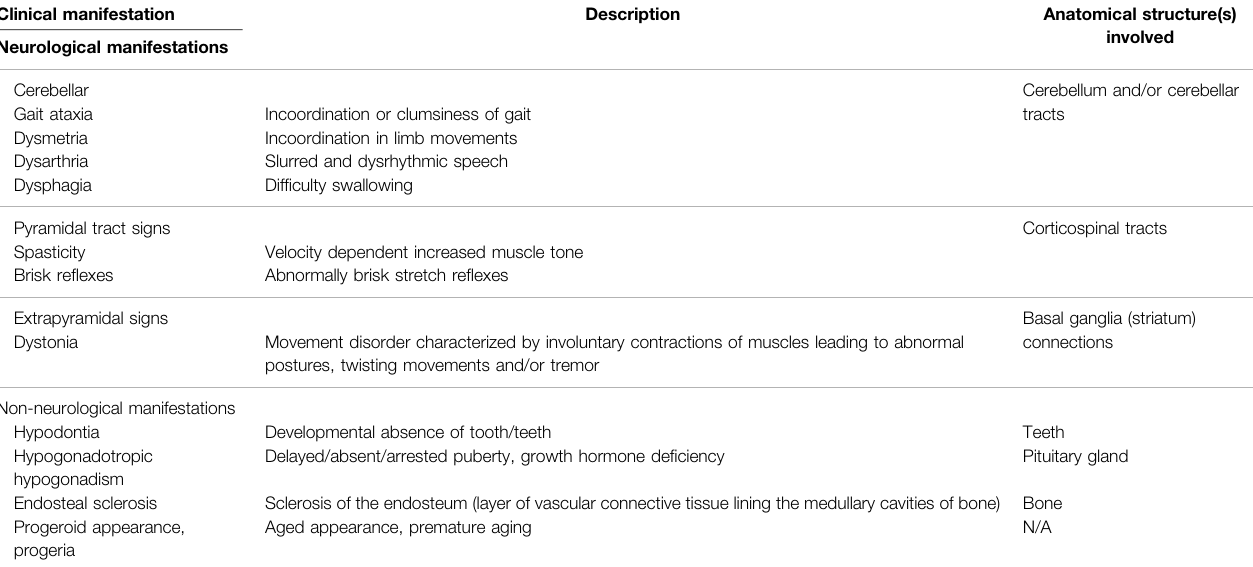
TABLE 1 | Description of the main clinical manifestations observed in POLR3-related disorders and anatomical structures